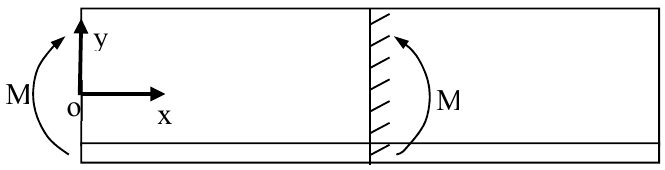
Figure 3. Schematic illustration of equivalent vertical bending cantilever beam.